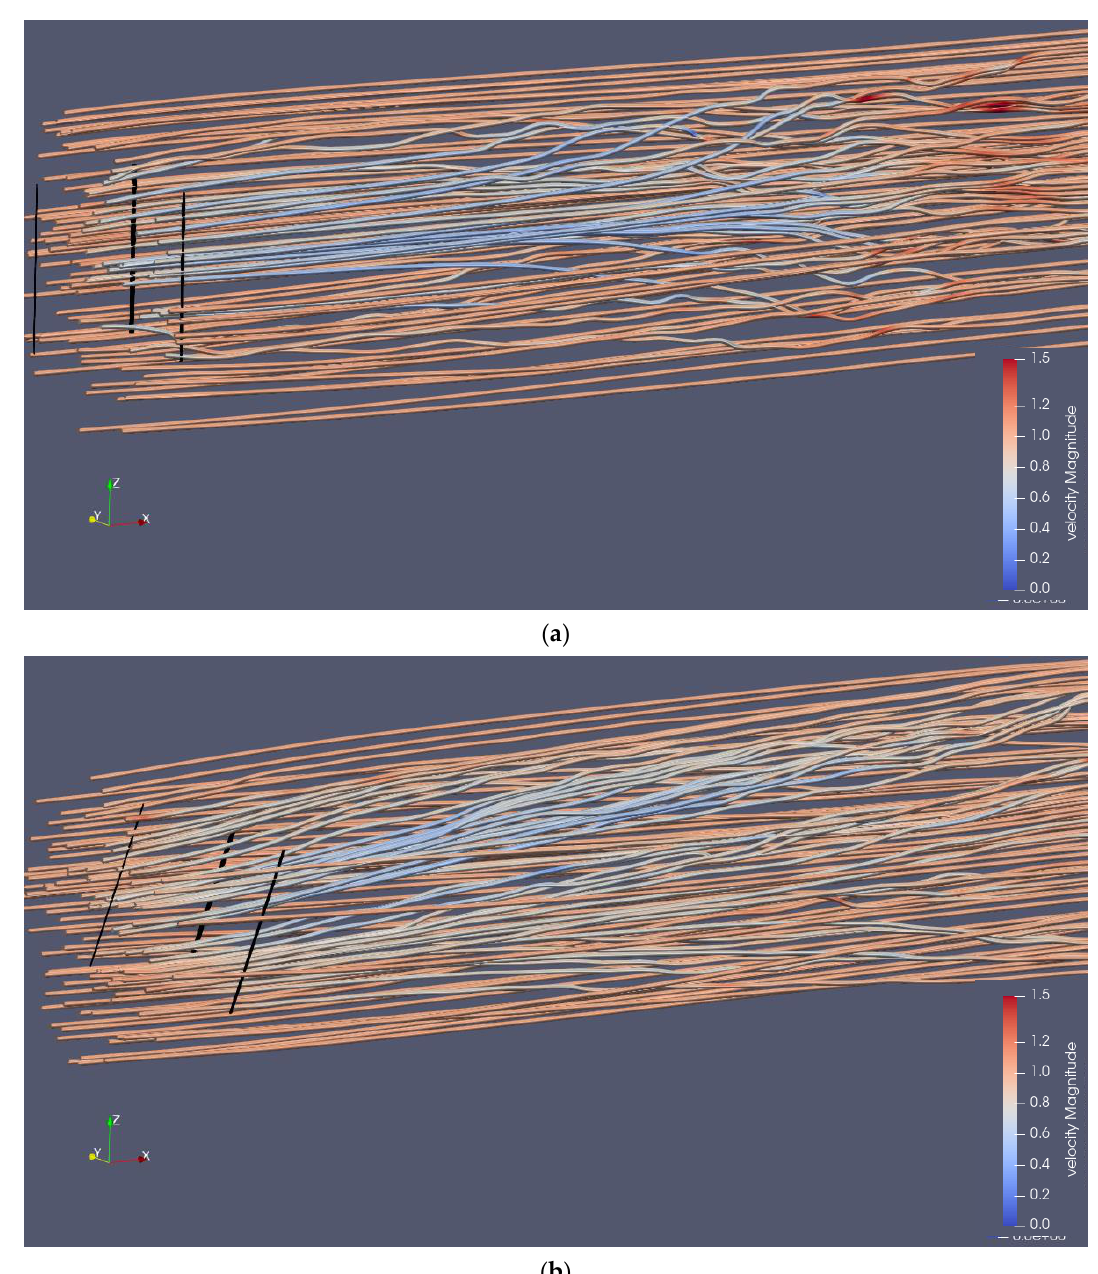
Figure 10. 3D Streamlines ( a ) upright; ( b ) 20-degree